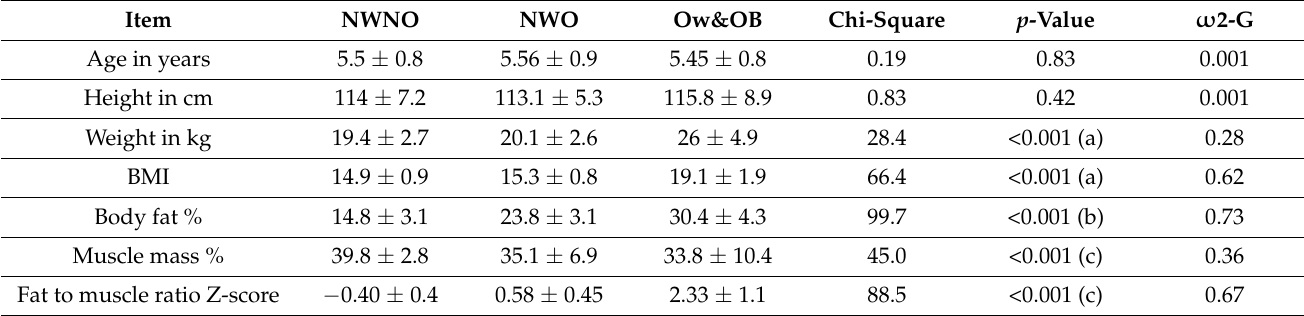
Table 3. Anthropometry description of NOW, NWNO and Ow&Ob children.